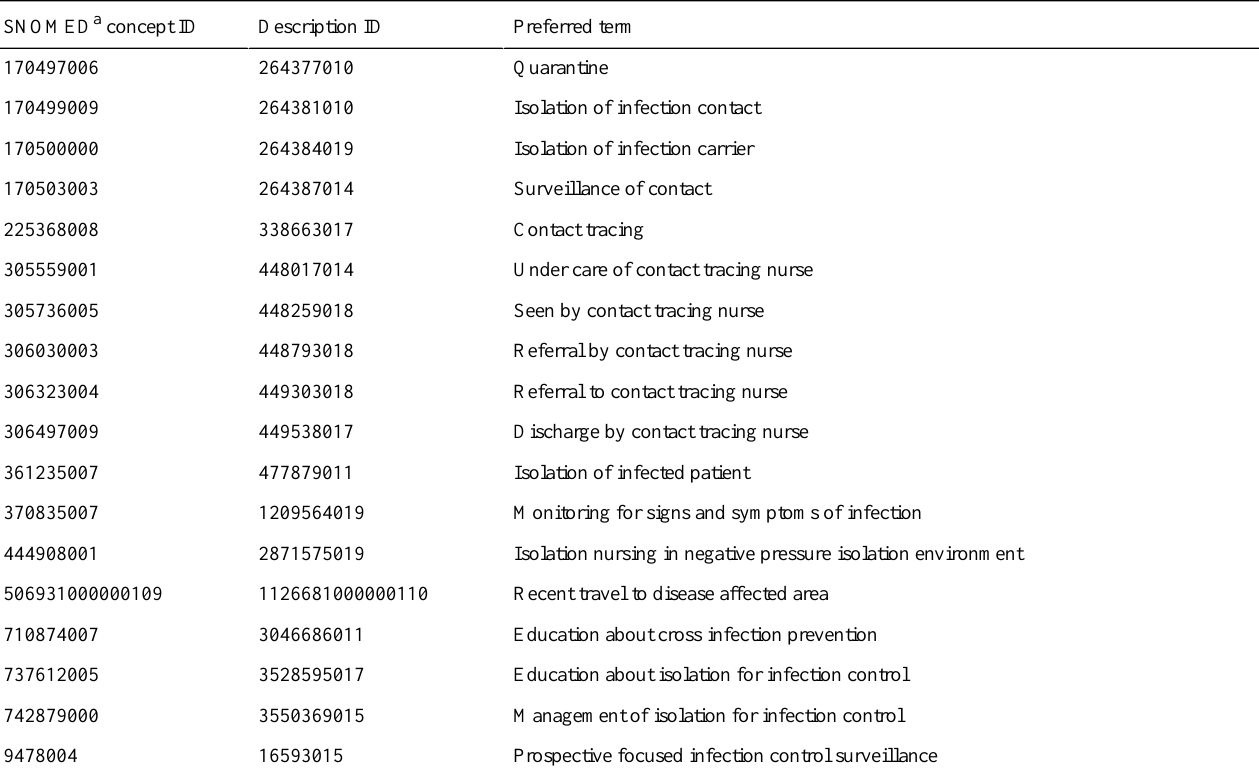
Table 1. Codes in the Systematized Nomenclature of Human Medicine to flag control measures and audit their effectiveness.